Question: In one sentence, what is this figure communicating?
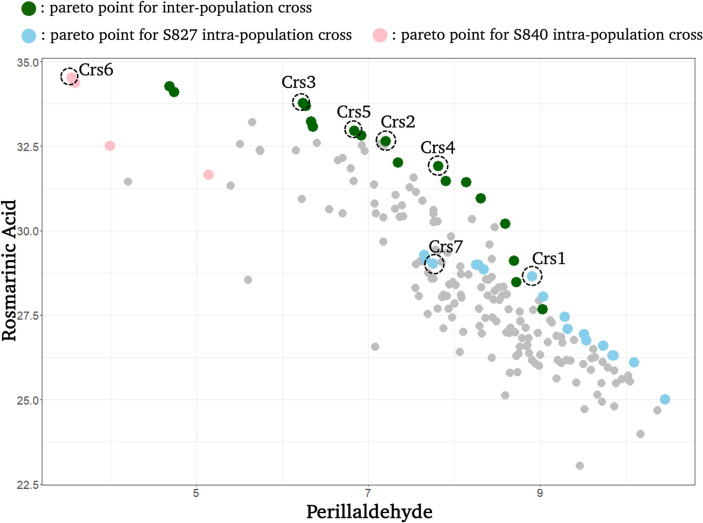
Answer: Prediction of additive genotypic value in G₂ progeny based on marker genotype data of the F₄ generation obtained by simulation. Each point represents one of the 196 F₄ cross pairs. The plotted value indicates the predicted cross performance, defined as the average value of the 20th-ranked individual among 2,000 simulated G₂ progeny across 500 simulation replicates. Dark green, sky blue, and pink points indicate the Pareto-optimal crosses derived from inter-population crosses, intra-population crosses within S827, and intra-population crosses within S840, respectively. Points enclosed by dashed circles correspond to the crosses actually used to produce the G₂ generation. Labels Crs1–7 denote the names of the specific crosses used in this study